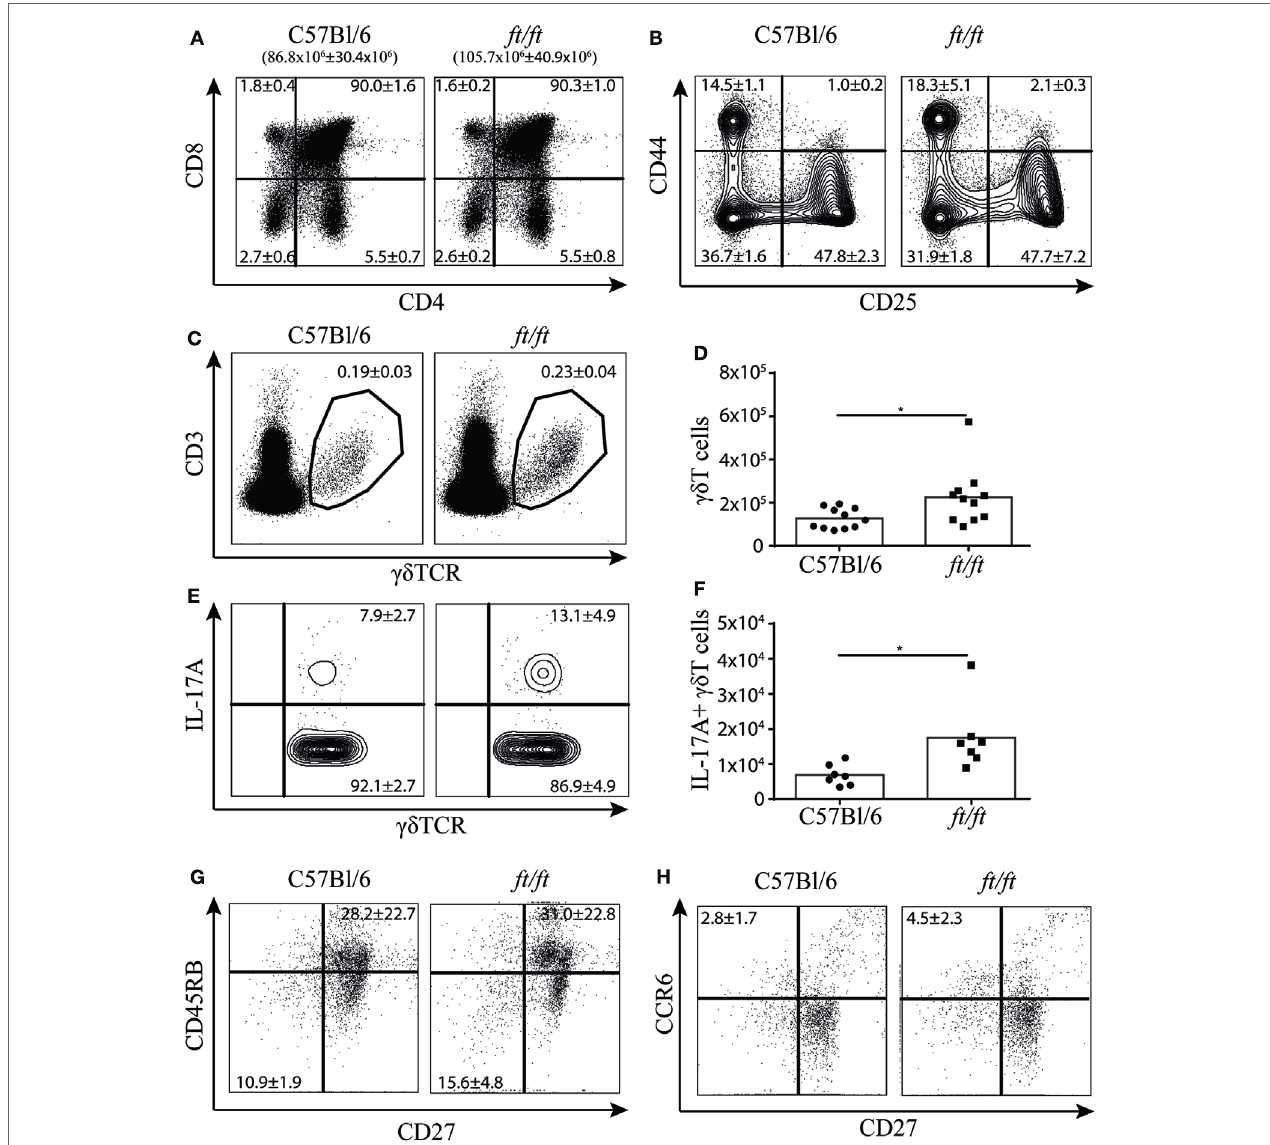
FigUre 2 | Increased numbers of γδ T17 cells in the thymus of ft/ft mice. (a–h) Flow cytometric analyses of thymocytes from 8 to 12 weeks old C57Bl/6 and ft/ft mice. (a) Plots showing CD4 and CD8 staining of total thymocytes. The total numbers of thymocytes are given above the plots. (B) Plots showing CD25 and CD44 staining on the double negative CD4 − CD8 − thymocyte population. (c,D) Fraction and absolute numbers of CD3 ε + TCR γδ + thymocytes. (e,F) Fraction and absolute numbers of IL-17 + TCR γδ + thymocytes. (g,h) Dot plots showing CD27 versus CD45RB and CD27 versus CCR6 expression of TCR γδ + thymocytes. Data are representative of two to four independent experiments with two to four mice in each. The mean percentages ± SD are given for the relevant populations in the